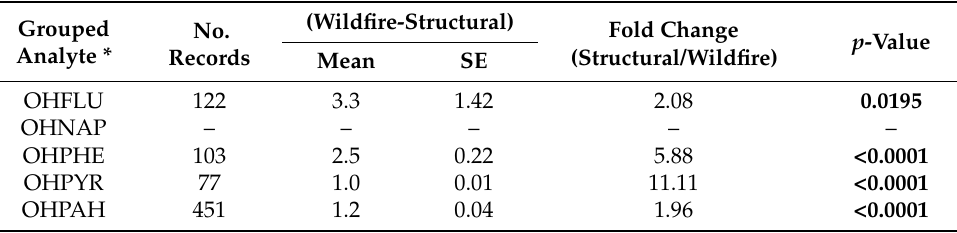
Table 5. Structural and wildland fire comparison of hydroxylated PAH (OHPAH) collected from urine samples (unit: ng/g—creatinine) by grouped analytes. Bold p -value indicates a statistically significant difference in urinary OHPAH levels between structural and wildland fire activity. (Wildfire-Structural) Fold Change Grouped No. Analyte * (Structural/Wildfire) Records –